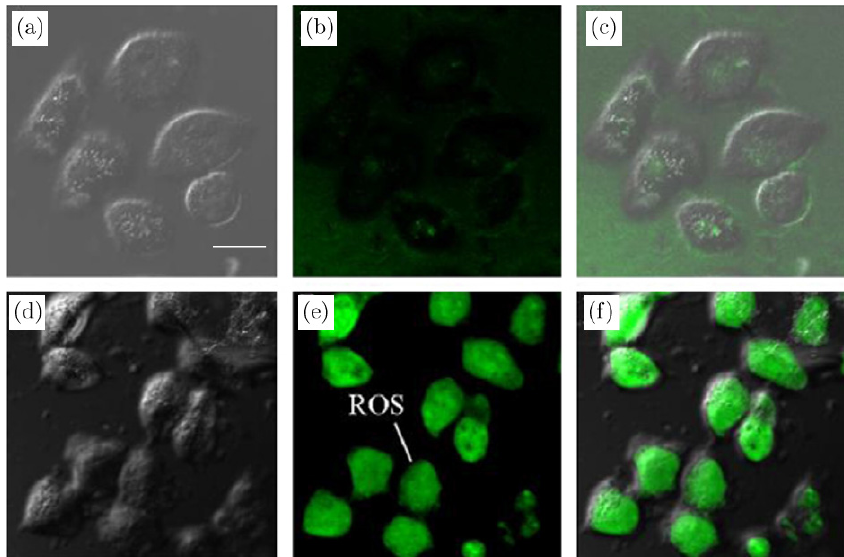
Fig. 8. ROS production in HepG2 cells treated with 0.5 (cid:2) M Photocyanine and irradiation (the lower panels) compared with that of untreated cells (the upper panels). (a) and (d) — bright ¯eld; (b) and (e) — °uorescent images in the presence of ROS probe; (c) and